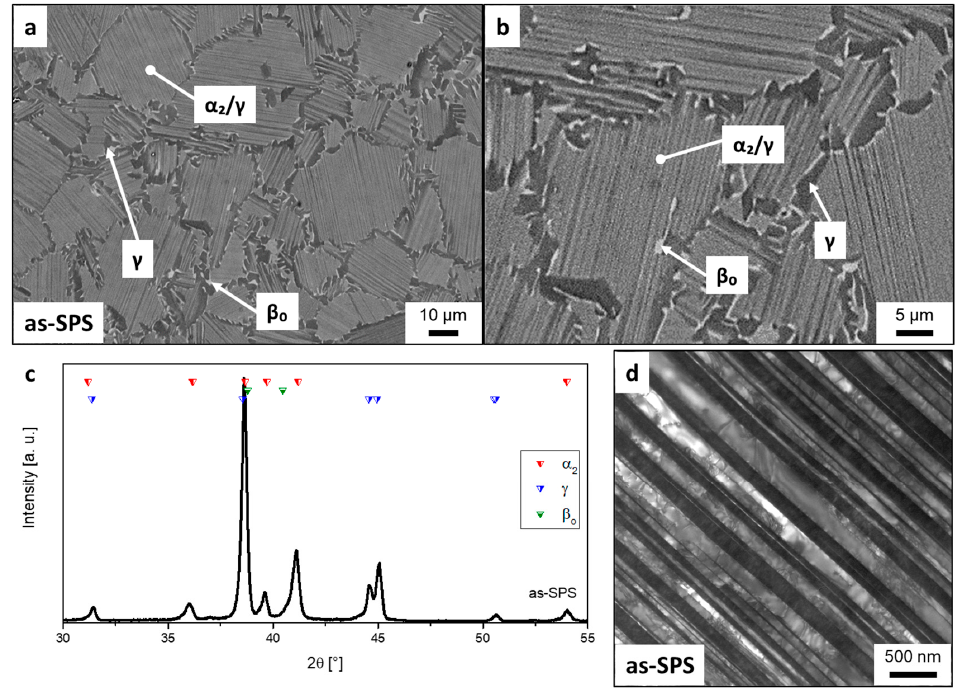
Figure 1. ( a , b ) NL γ + β o microstructure of the as-SPS TNM alloy consisting of equiaxed lamellar α ₂ / γ -colonies surrounded by globular γ - and β o -phase. Owing to the low cooling rate from the dwell temperature (1300 °C), the lamellar spacing is rather large. The SEM images were taken in BSE mode, thus globular γ shows a dark contrast, whereas the β o -phase appears in bright contrast. The α 2 -phase shows a contrast between those of γ and β o . ( c ) XRD spectrum of as-SPS sample. The phase fraction evaluated by applying Rietveld analysis is listed in Table 2. ( d ) TEM image of a lamellar α 2 / γ -colony in an as-SPS specimen in “edge-on” condition.